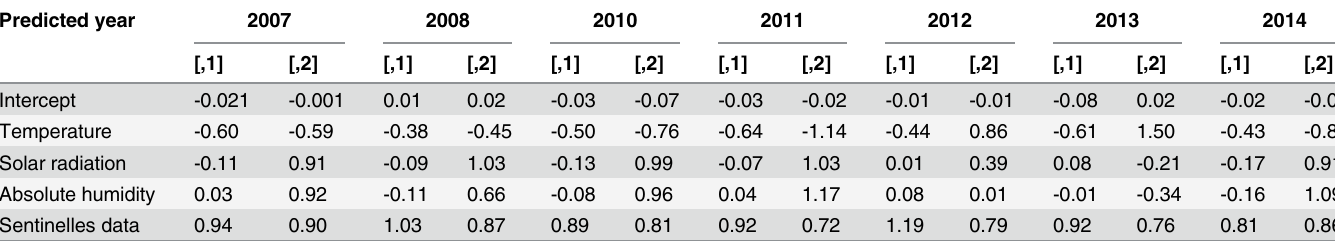
Table 5. LDA — Coefficients of discriminant factor son the two discriminant function axes, for each year